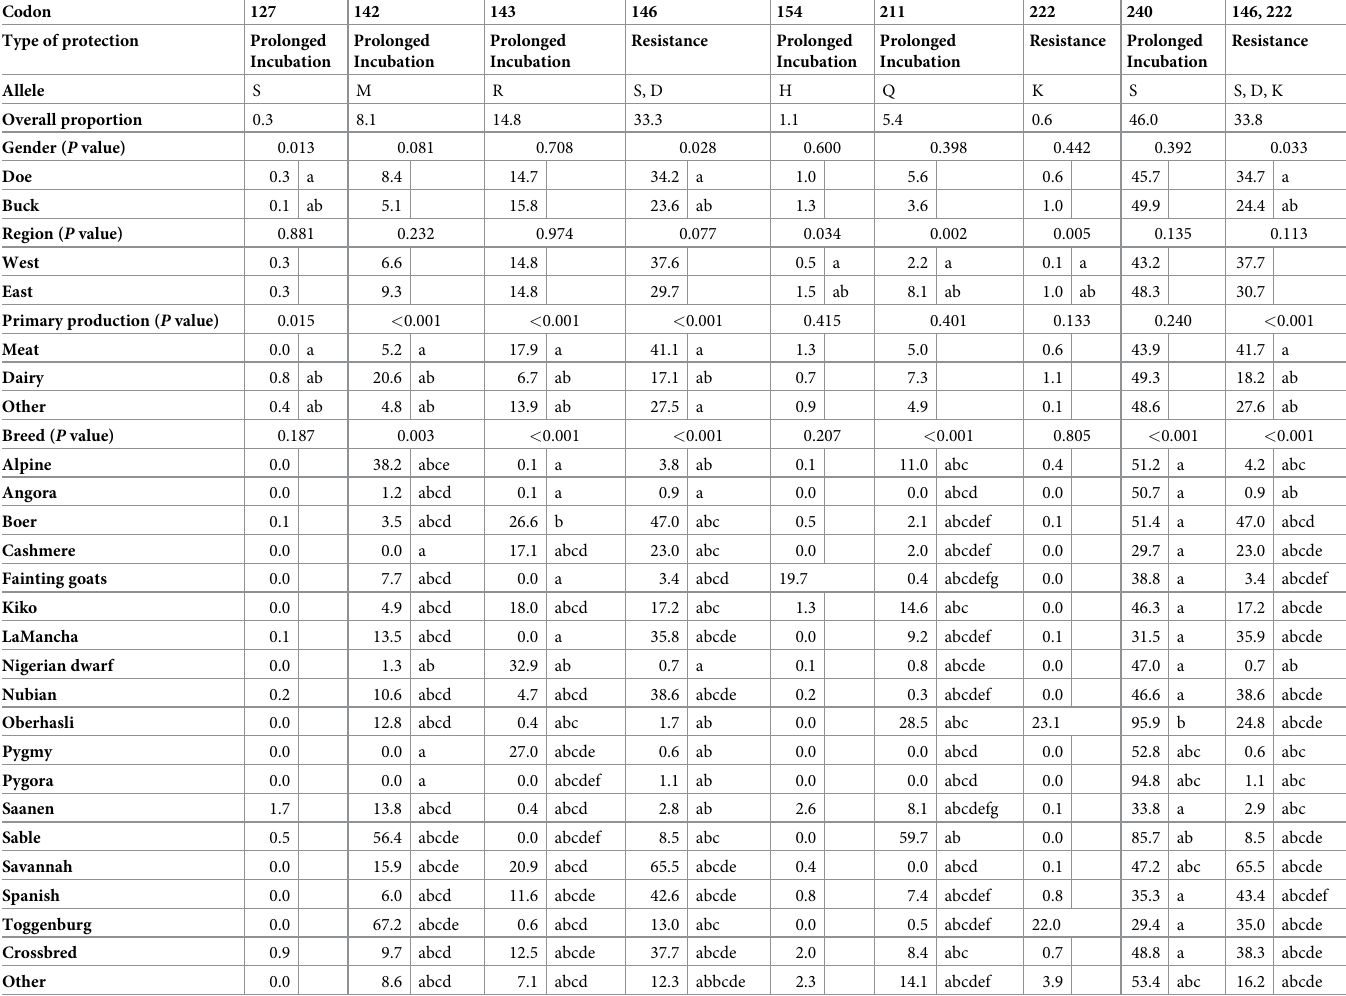
Table 1. Proportion of goats with genotypes associated with prolonged incubation period or resistant genotypes, by codon along with significance test results for overall effect of each breakout variable (gender, region, primary production, and